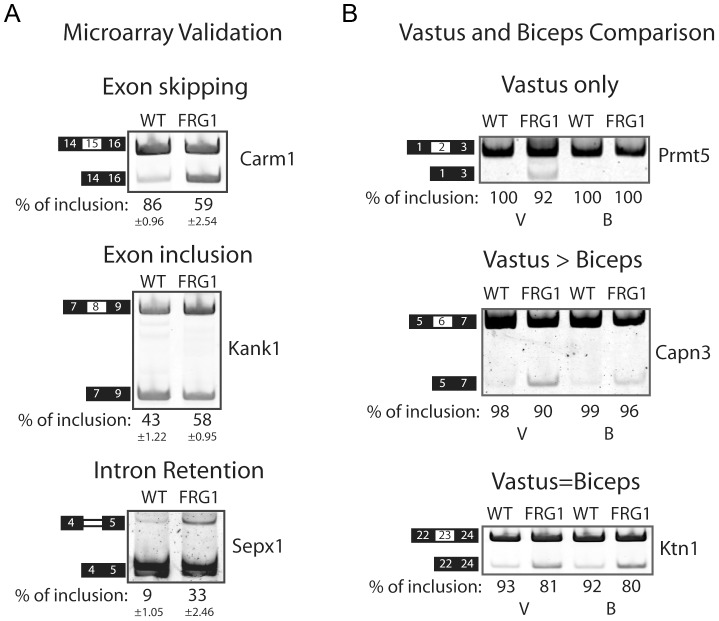
RT–PCR validation of splicing events belonging to different classes.(a) RT-PCR performed using RNA extracted from vastus lateralis muscle of FRG1 and control littermates (n = 3 per group, 4 weeks old mice). Examples of increased exon skipping (Carm1), exon inclusion (Kank1) or intron retention (Sepx1) in FRG1 mice is shown. RT-PCR products from three individual FRG1 and control WT mice were quantified using the Typhoon and the skipping rates were calculated. Samples were judged as being different from WT if a t-test indicated that the sample was unlikely to be from the WT distribution with P<0.05. (b) Examples of alternative exons affected only (Prmt5), primarily (Capn3) or similarly (Itga7) in FRG1 mice vastus lateralis compared to biceps brachii muscles. Numbers below gel images are the percentage of exon inclusion. Black boxes illustrate constitutive exons, white boxes alternatively spliced exons and double lines represent the affected intron.